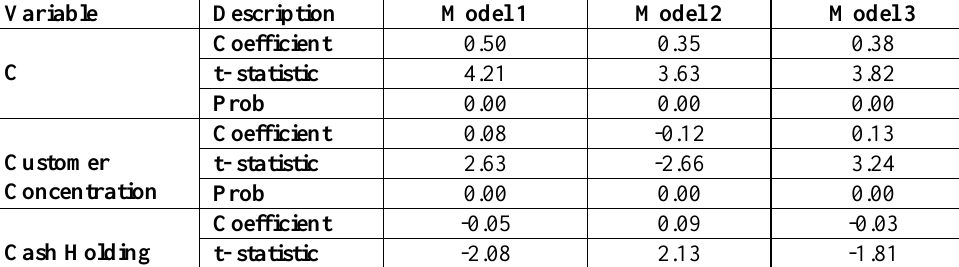
Table 6. Findings obtained from testing the research